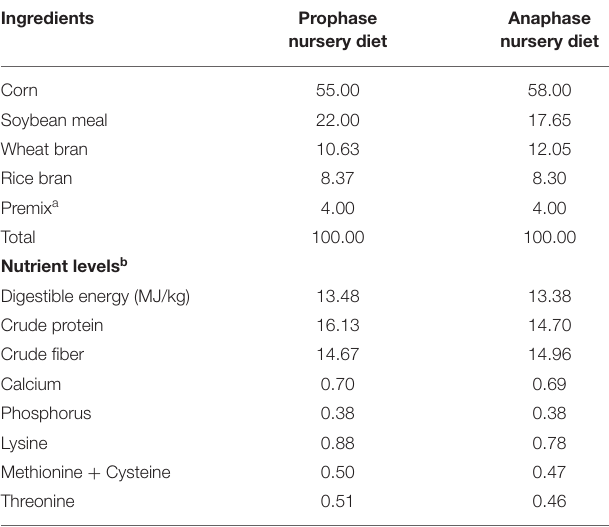
TABLE 1 | Compositions and nutrient levels of basal diets (air-dry basis)